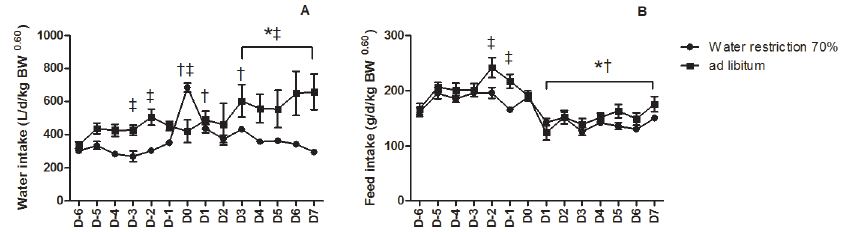
Figure 1. Effect of exposure to 32 6 C and water restriction on average daily feed and water intake. Mean 6 standard error. For each water restriction treatment each point represents the mean of 6 pigs. * means that daily value is significantly different ( P , 0.05) from values at 24 u C within the ad libitum group. { means that daily value is significantly different ( P , 0.05) from values at 24 u C within the water restricted group. ` means that daily value was significantly affected (P , 0.05) by water restriction treatment (i.e., significant daily value difference between the ad libitum group compared to the water restricted group).